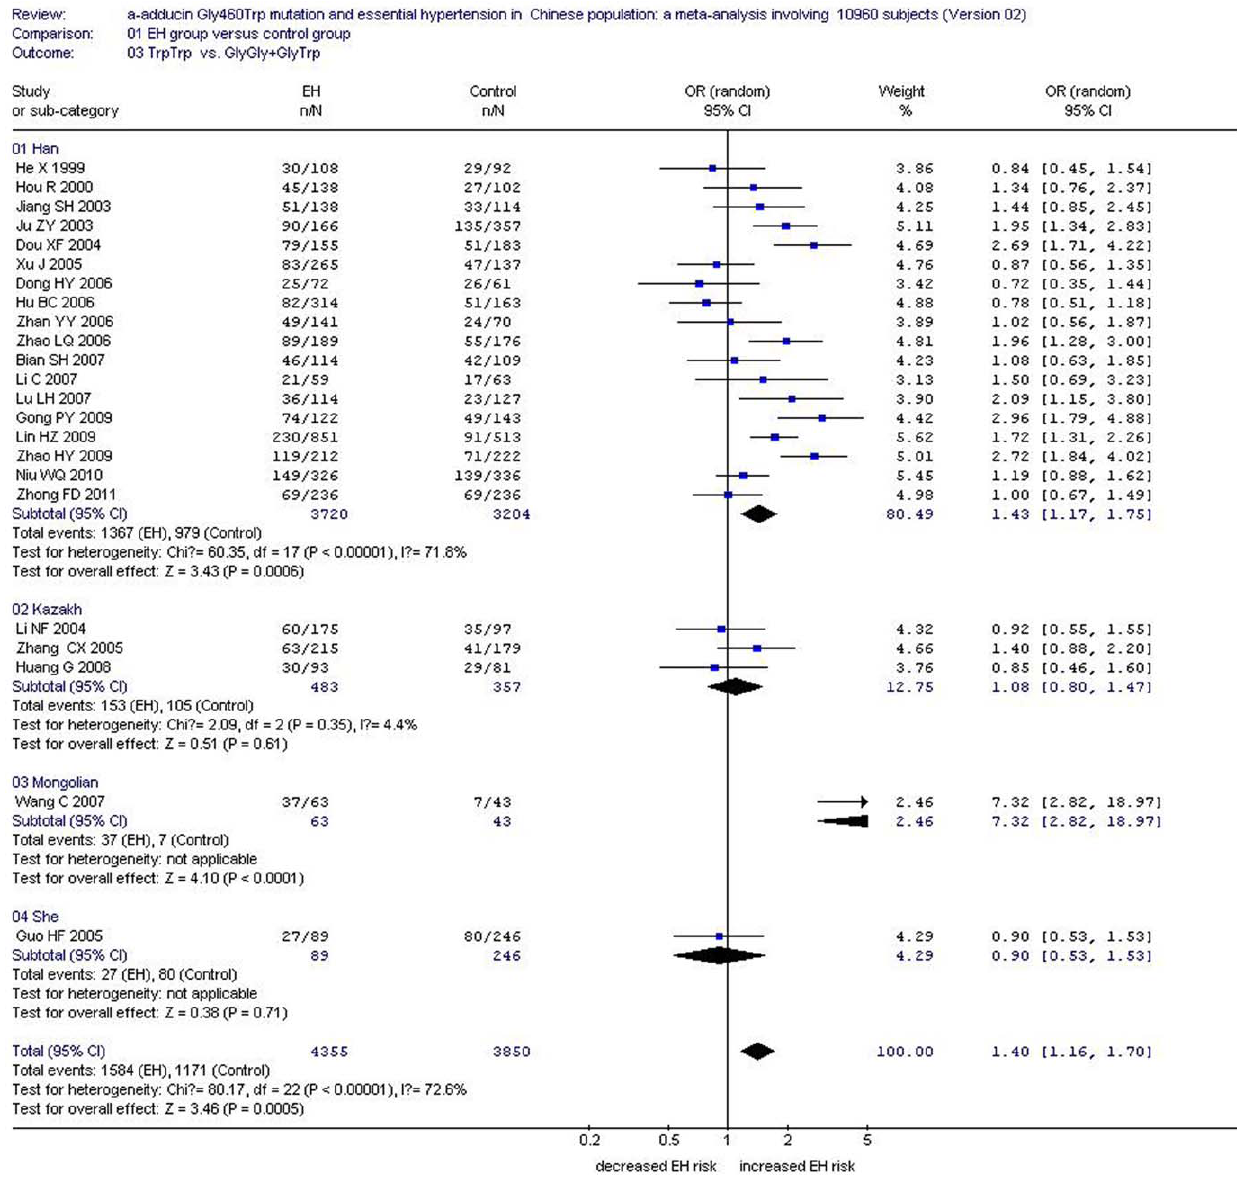
Figure 3. Forest plot of essential hypertension associated with a -adducin Gly460Trp gene polymorphism under a recessive genetic model (TrpTrp vs.GlyGly + GlyTrp) stratified by ethnicity.